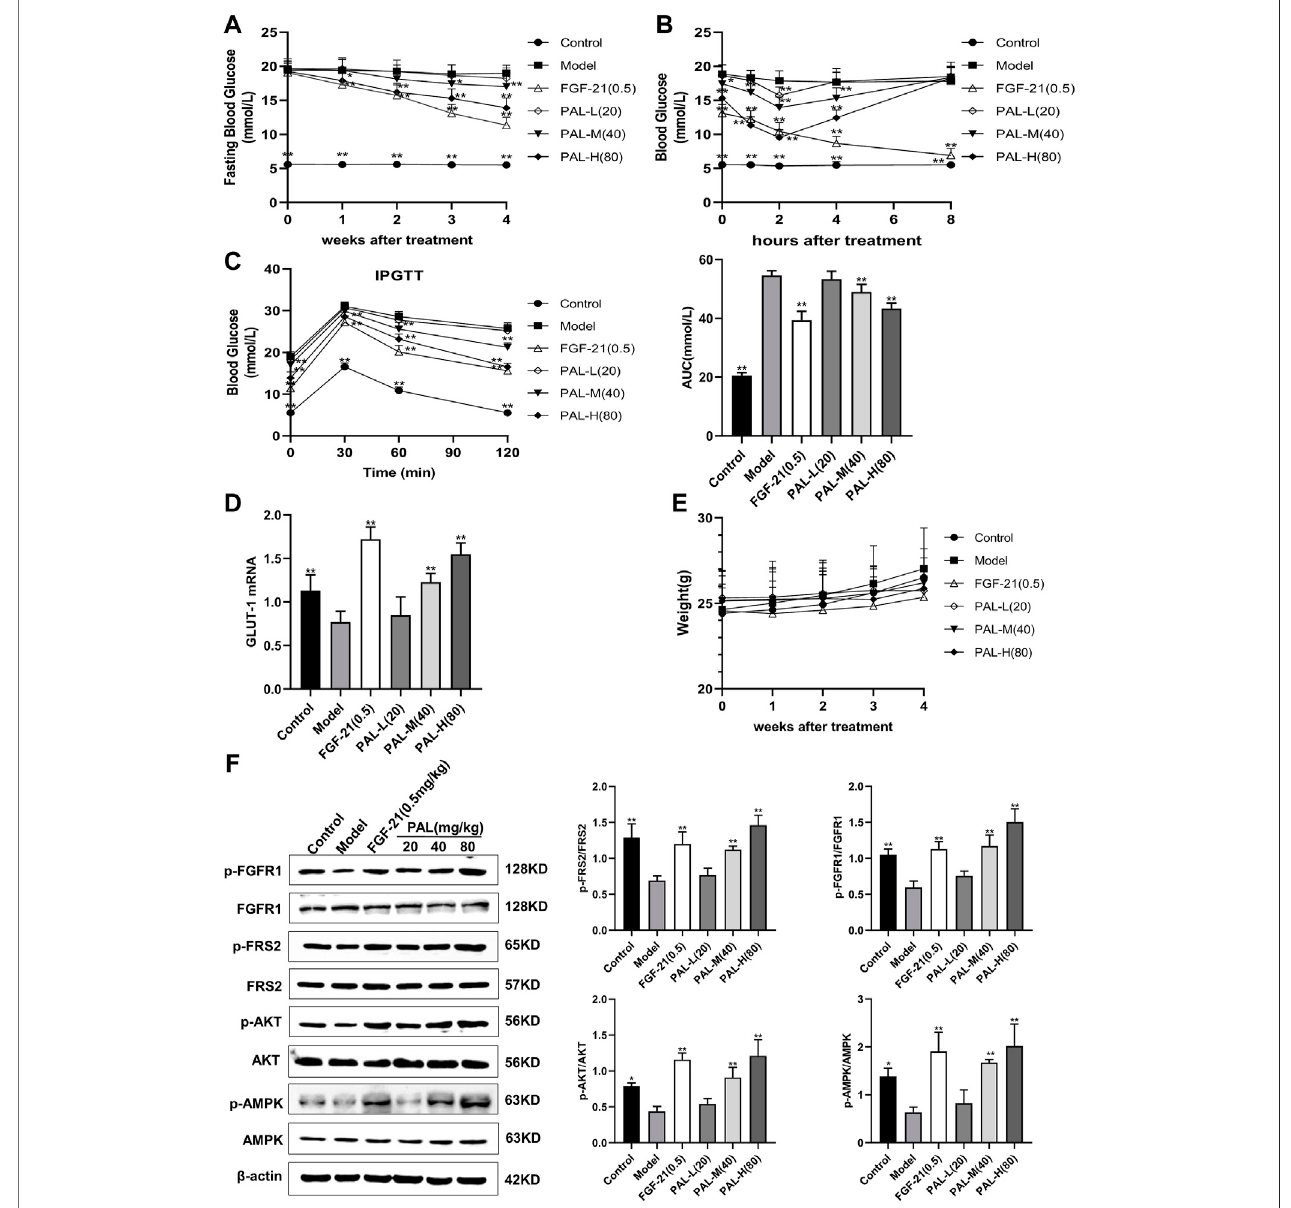
FIGURE 6 | The effect of palmatine (PAL) on the fi broblast growth factor receptor 1 (FGFR1) pathway in mice with streptozotocin (STZ)-induced diabetes. (A) fasting bloodglucoseinmicetreatedwithPALfor4weeks. (B) changesinblood glucoselevelsovertimeinmiceonday28ofPALtreatment. (C) intraperitonealglucose tolerance test (IPGTT) after 4 weeks of PAL treatment. (D) the relative mRNA level of glucose transporter type 1 (GLUT-1) in the livers of mice in each group. (E) weight changesin mice treatedwithPAL for 4weeks (F) quantitative analysisof theexpression levels ofp-FGFR1and FGFR1 (p-FGFR1/total FGFR1), p-FRS2 and FRS2 (p-FRS2/total FRS2),p-AKTand AKT(p-AKT/total AKT),and p-AMPK andAMPK(p-AMPK/total AMPK)using westernblot.Dataarepresented asmeans±SD, n =12. * p < 0.05, ** p < 0.01, versus the model group.